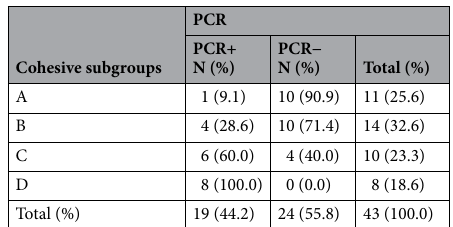
Table 2. The relationship of actors belonging to the different cohesive subgroups and PCR results.